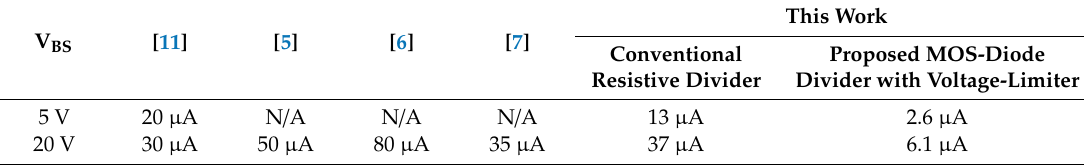
Table 1. Performance comparison of high-side quiescent current.